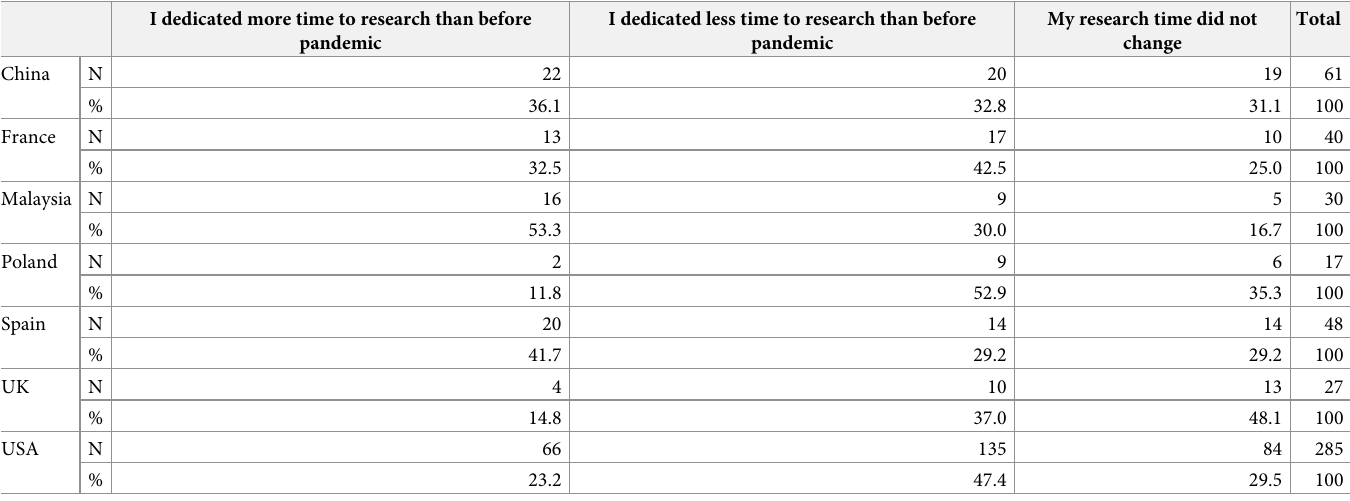
Table 5. Country differences for change in research